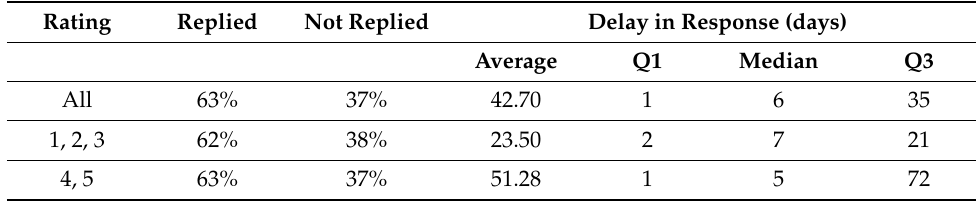
Table 5. Statistics on the companies’ responses to users’ comments.